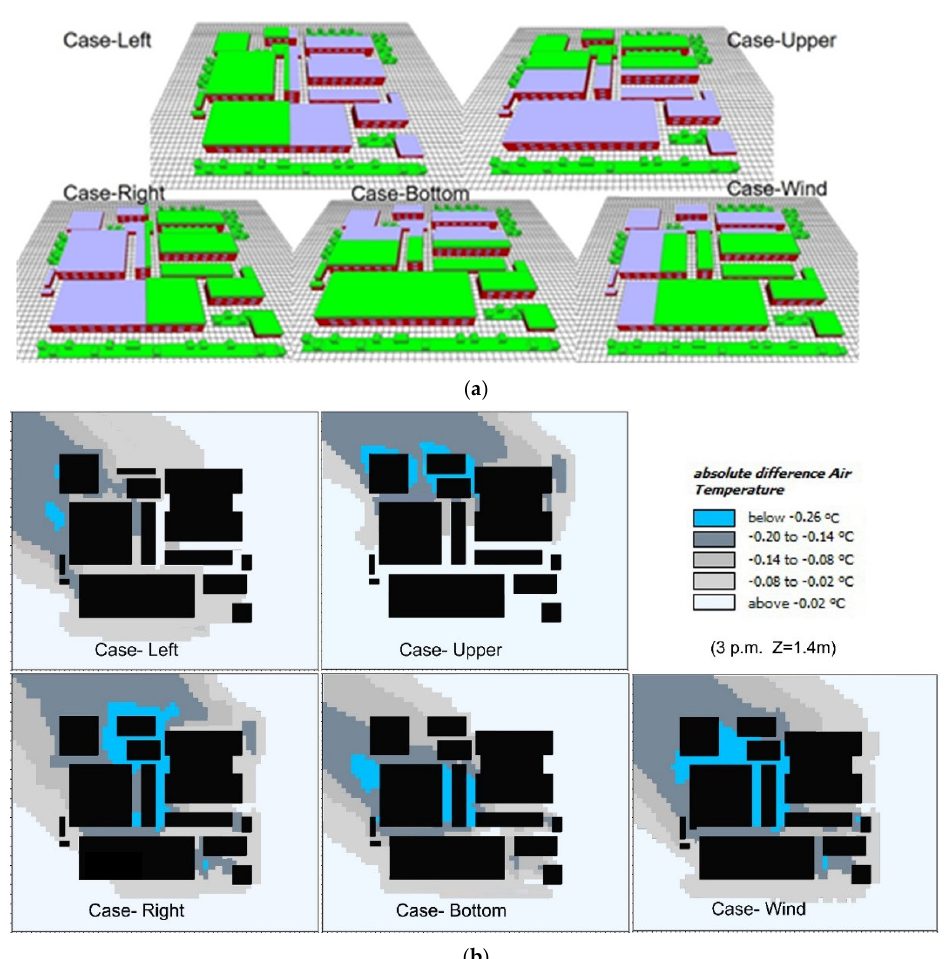
Figure 9. Comparison of the impact of greening layout on green roof cooling performance ( a ) Physical models, and ( b ) pedestrian air temperature reduction at 15:00 h.